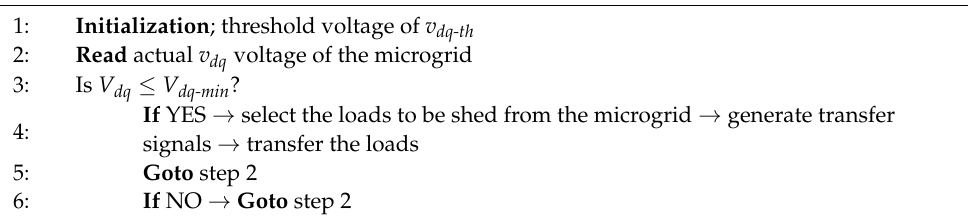
Algorithm 2 Pseudocode of SSTS transfer